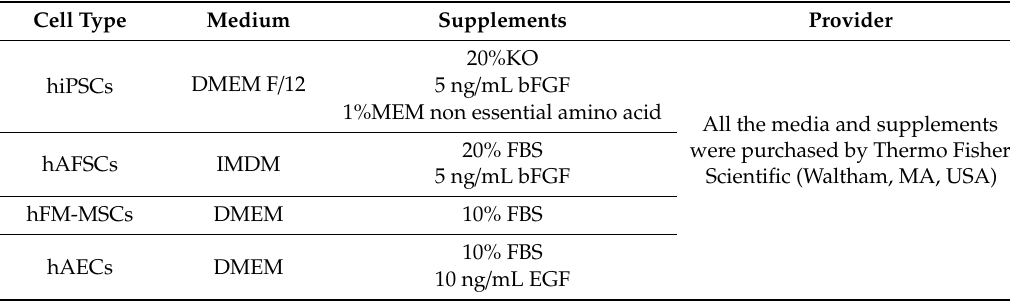
Table 1. Cell media and supplements.